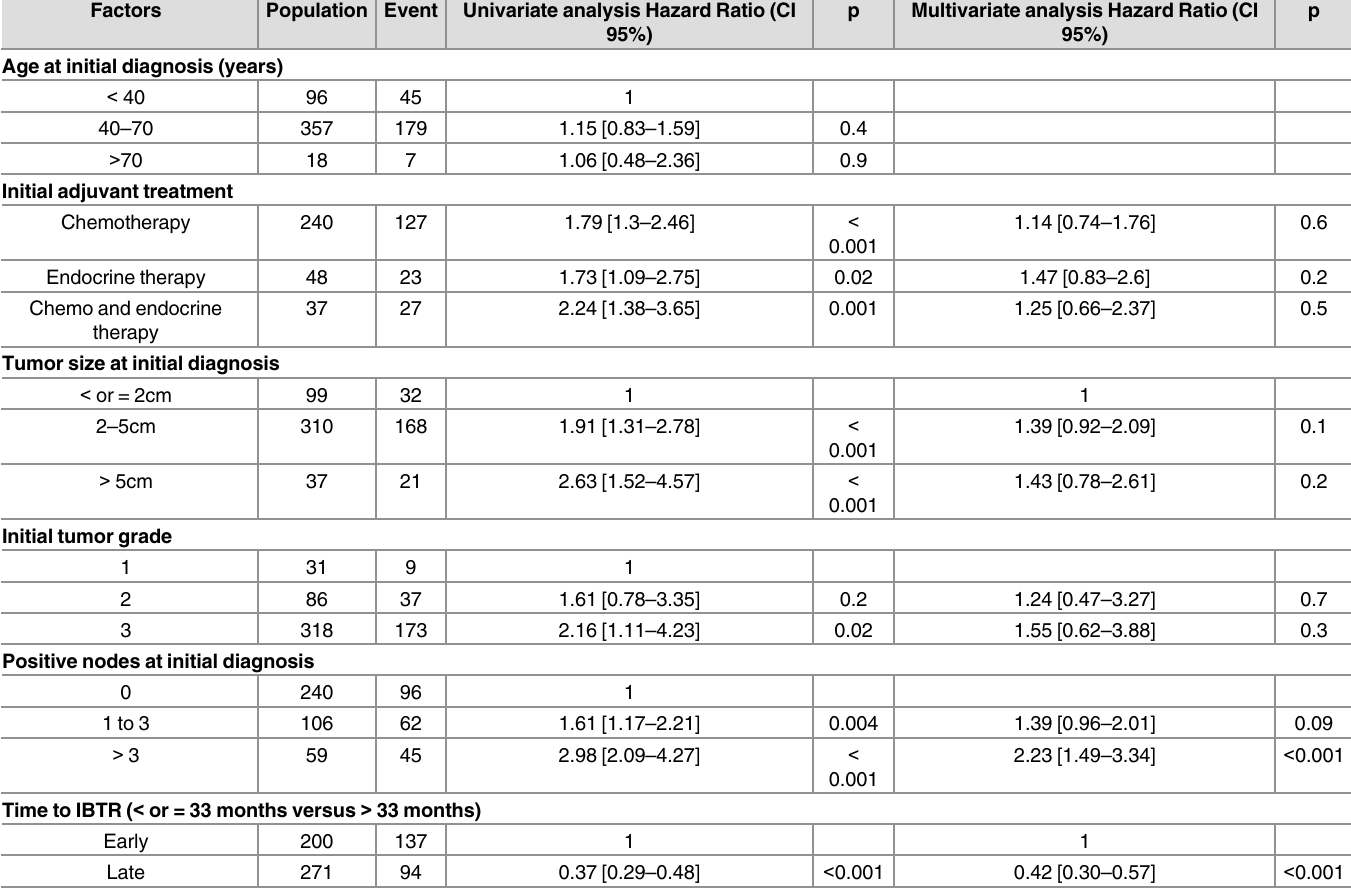
Table 3. Prognostic factors for post relapse disease free survival – hormone receptor negative